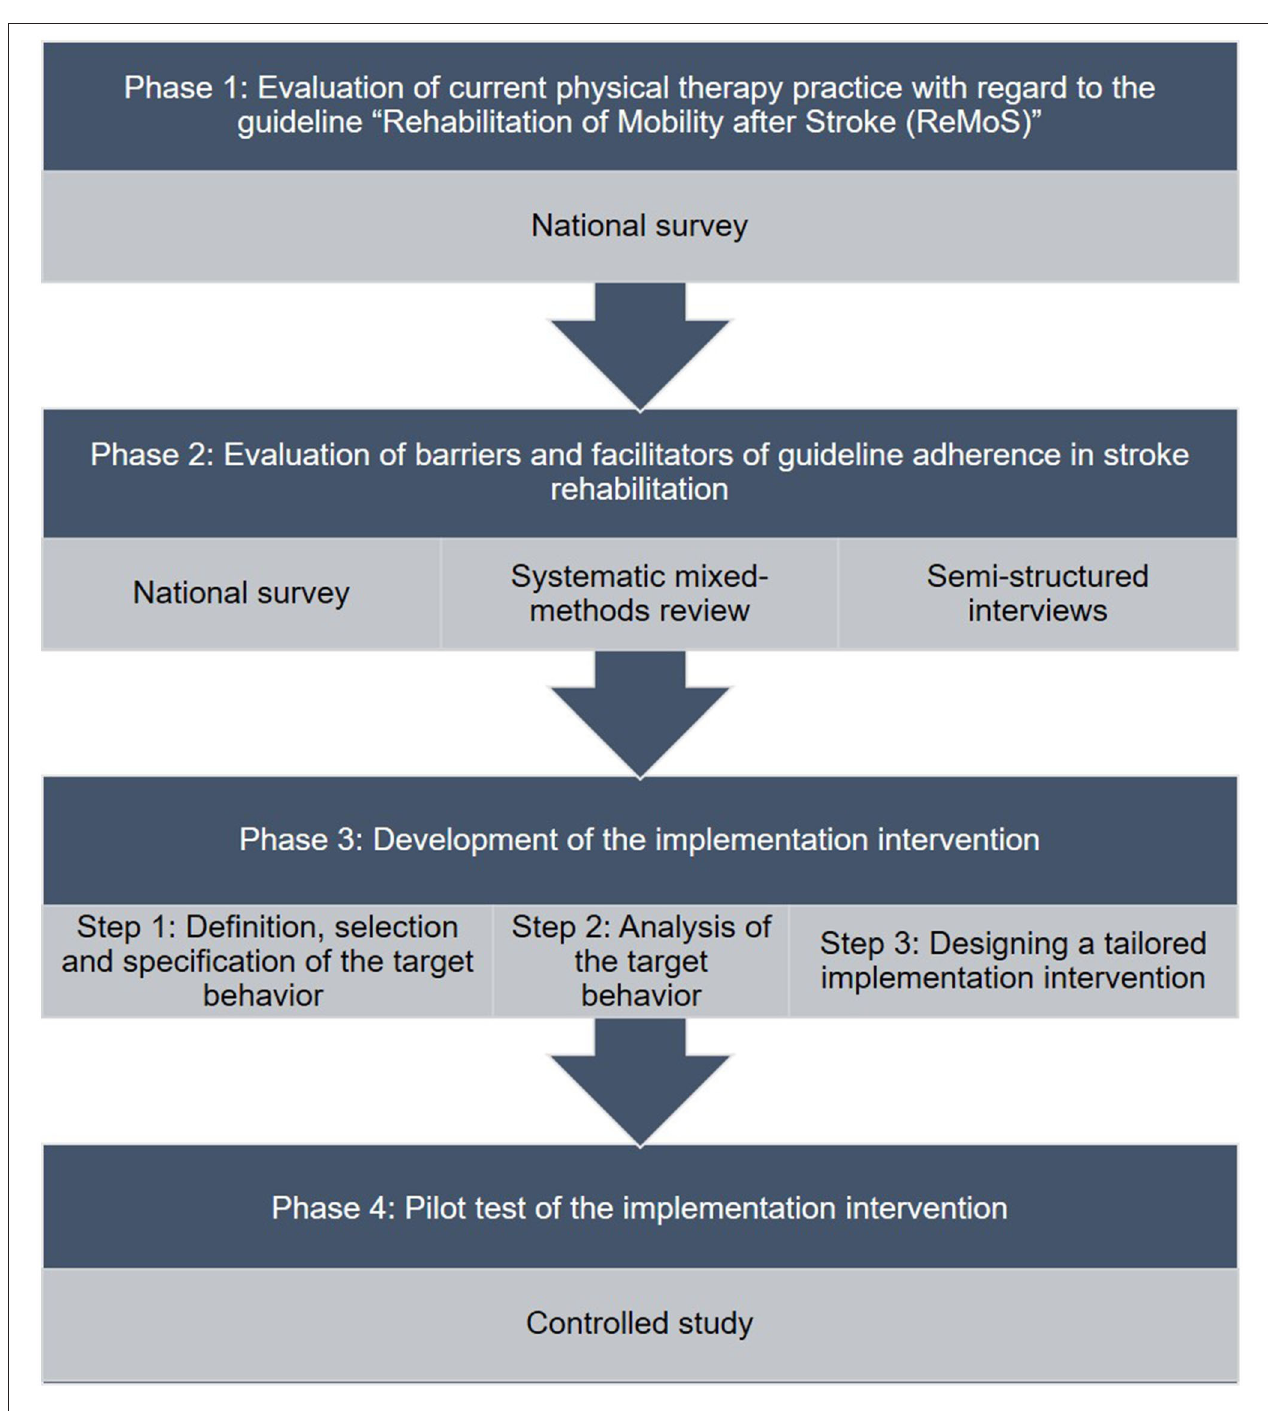
FIGURE 1 | Flow chart of study